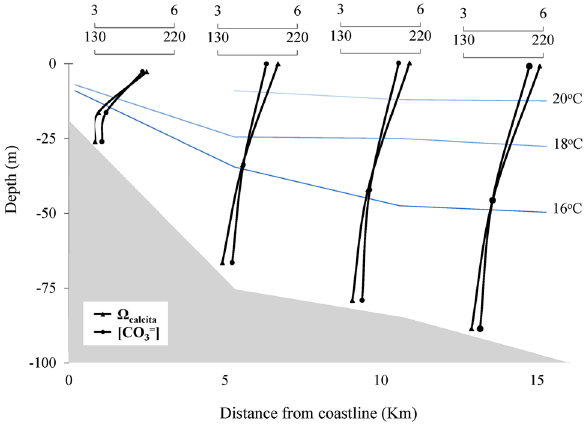
Figure 9. Calcite saturation state (Ω Calcite ) and carbonate concentration (µmol/kg) of the longitudinal samples from the water column’s surface, middle, and